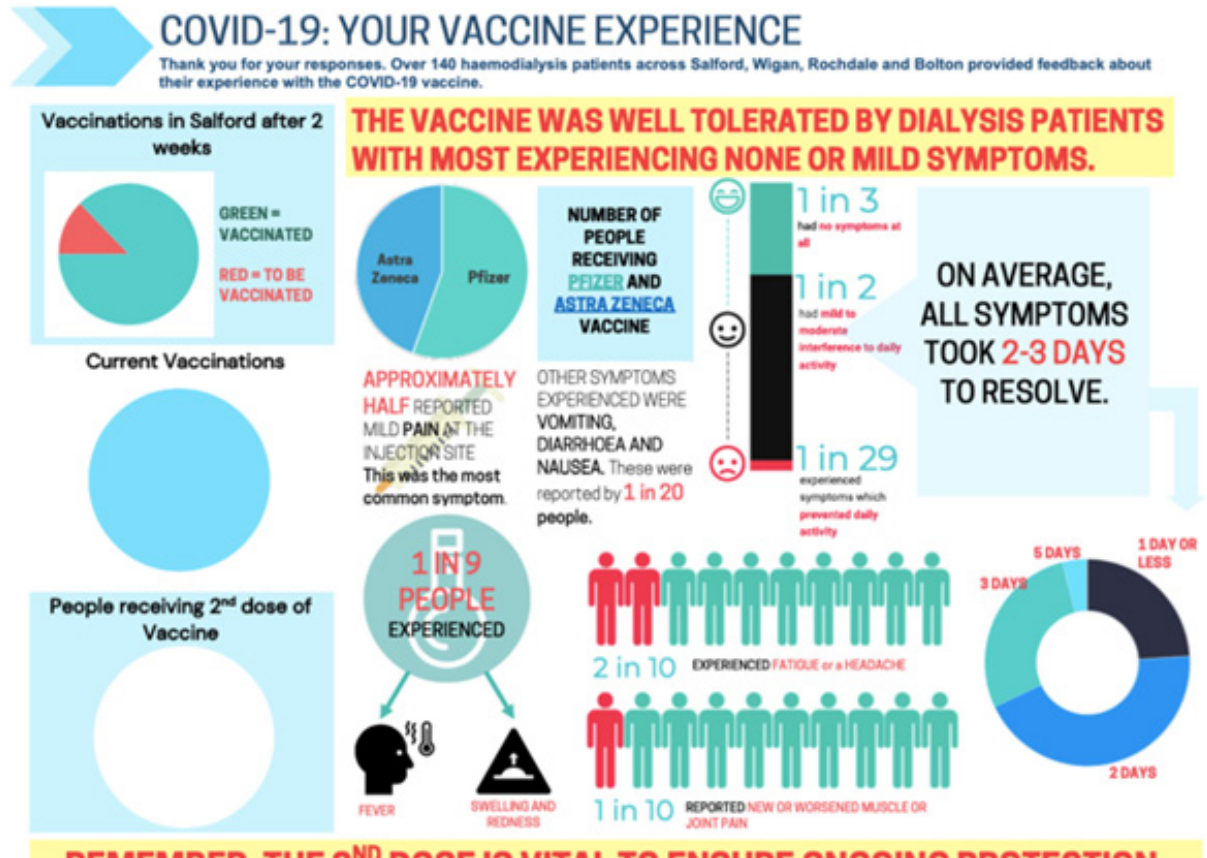
Figure 2. Poster example summarising the results of the local safety audit of 144 patients after receiving the first dose of COVID-19 vaccination.